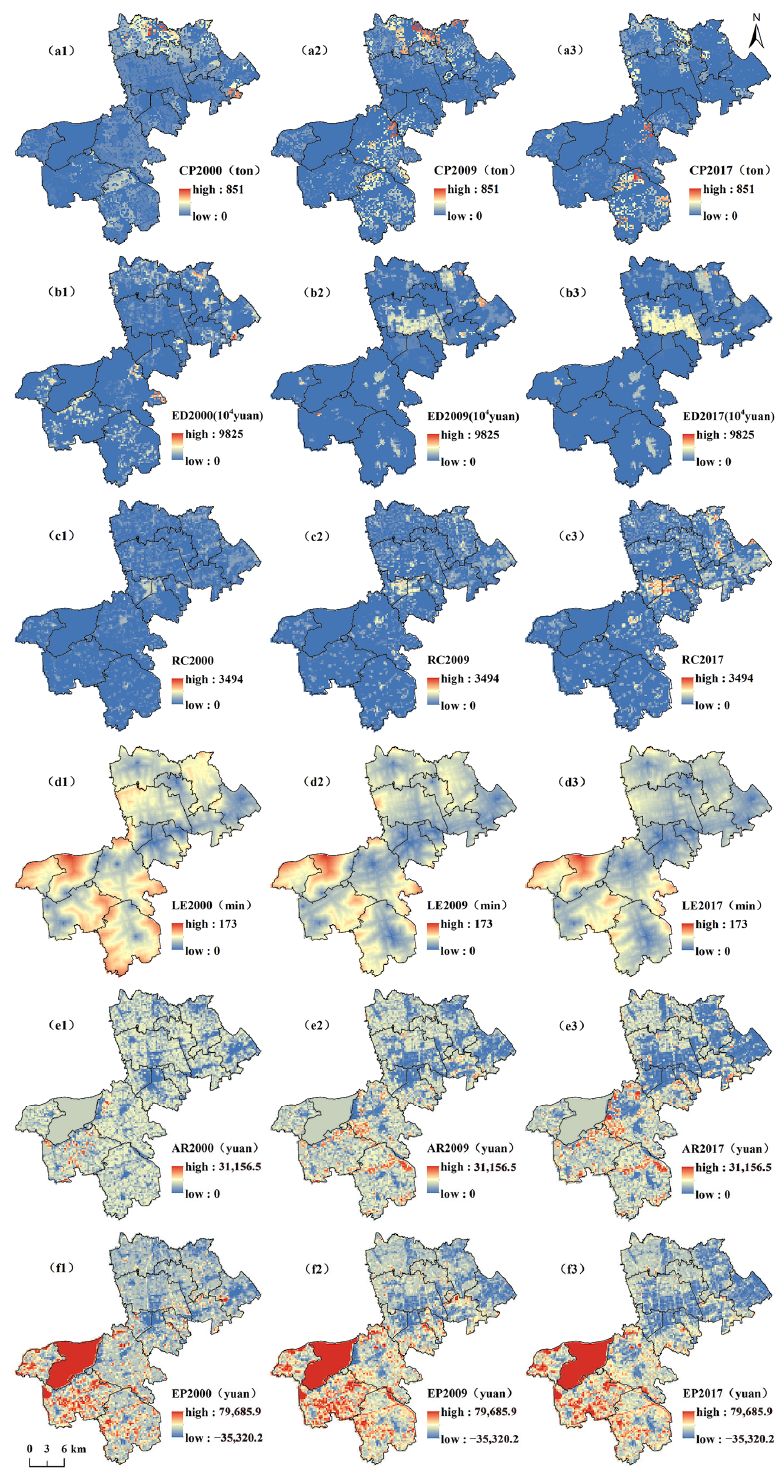
Figure 3. Spatial distribution of land use subfunctions in Qingpu District from 2000 to 2017. The land use subfunctions include crop production (CP) in 2000 ( a1 ), 2009 ( a2 ) and 2017 ( a3 ); economic development (ED) in 2000 ( b1 ), 2009 ( b2 ) and 2017 ( b3 ); residential carrier (RC) in 2000 ( c1 ), 2009 ( c2 ) and 2017 ( c3 ); leisure and entertainment (LE) in 2000 ( d1 ), 2009 ( d2 ) and 2017 ( d3 ); air regulation (AR) in 2000 ( e1 ), 2009 ( e2 ) and 2017 ( e3 ); environmental purification(EP) in 2000 ( f1 ), 2009 ( f2 ) and 2017 ( f3